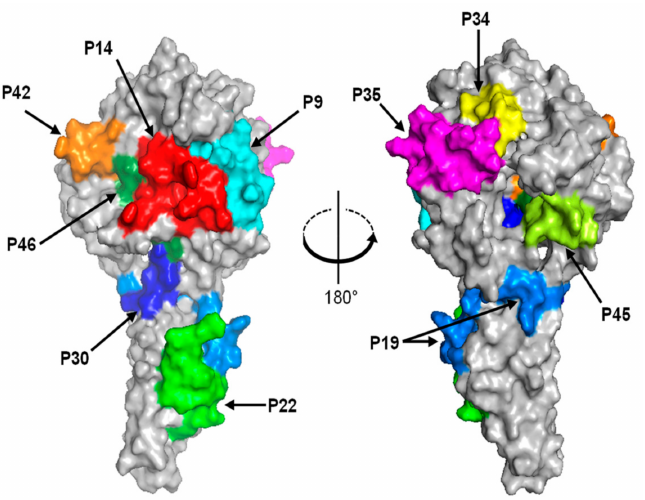
Figure 3. Mapping of the identified epitope regions on the CCHFV NP molecule. The monomeric structure of the CCHFV NP molecule is shown as a surface model. Amino acid locations in the 3D structure of the 10 peptides shown in Table 3 are depicted in distinct